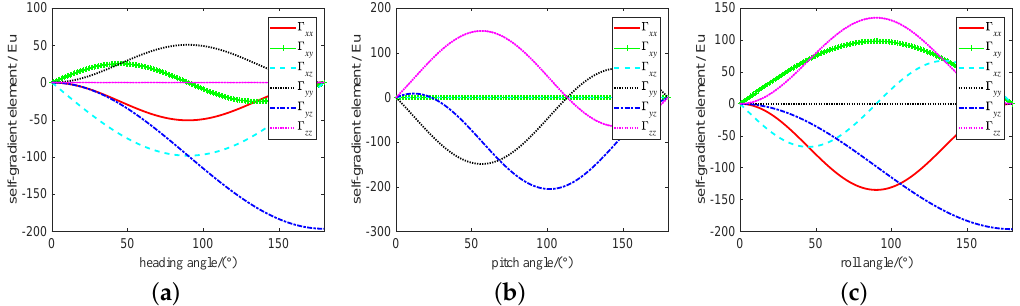
Figure 3. Self-gradient caused by the distribution mass of the carrier in different attitudes. ( a ) Self-gradient caused by the distribution mass of the carrier in heading attitude. ( b ) Self-gradient caused by the distribution mass of the carrier in pitch attitude. ( c ) Self-gradient caused by the distribution mass of the carrier in roll attitude.